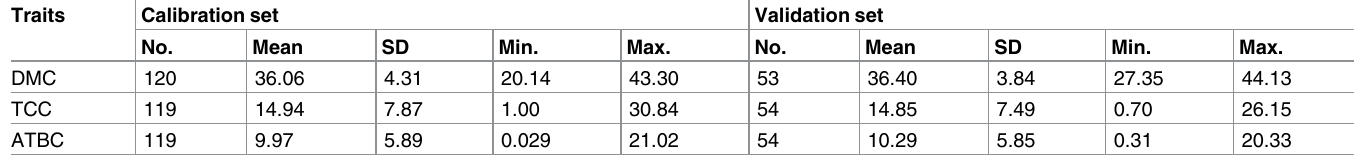
Table 2. Descriptivestatistics for model calibrations and independent set validations for DMC, TCC and ATBC using mashed root samples from CIAT, 2016. Traits Calibration set Validation